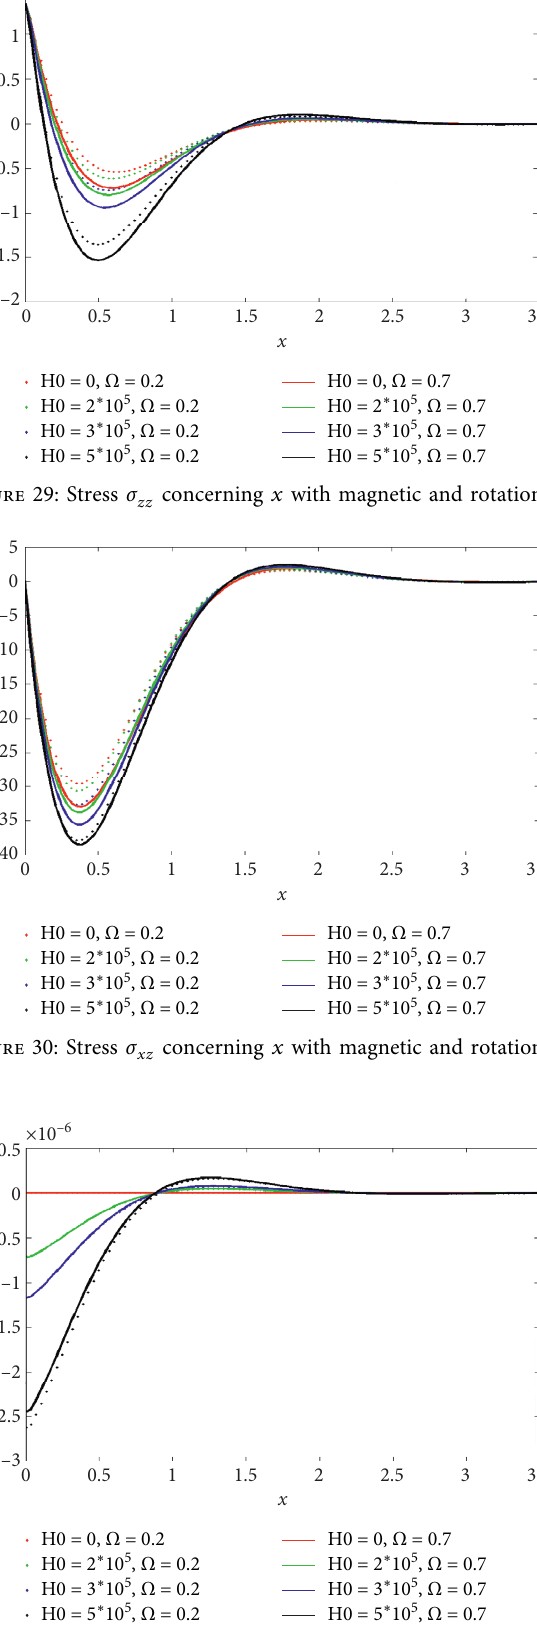
Figure 31: Stress τ x with magnetic and rotation. zz concerning